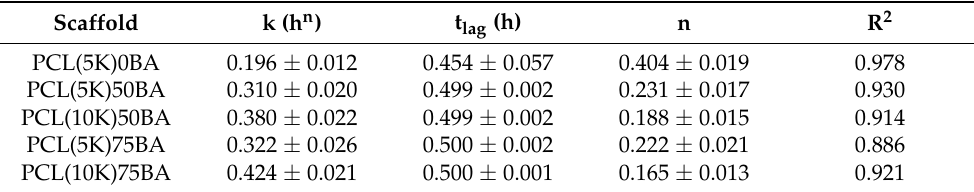
Table 2. Kinetic fitting parameters to the Korsmeyer-Peppas with lag time drug release model (Equation (2)) of ketoprofen released from PCL-scaffolds obtained by sc-foaming in PBS pH 7.4 medium at 37 ◦ C and 60 rpm.